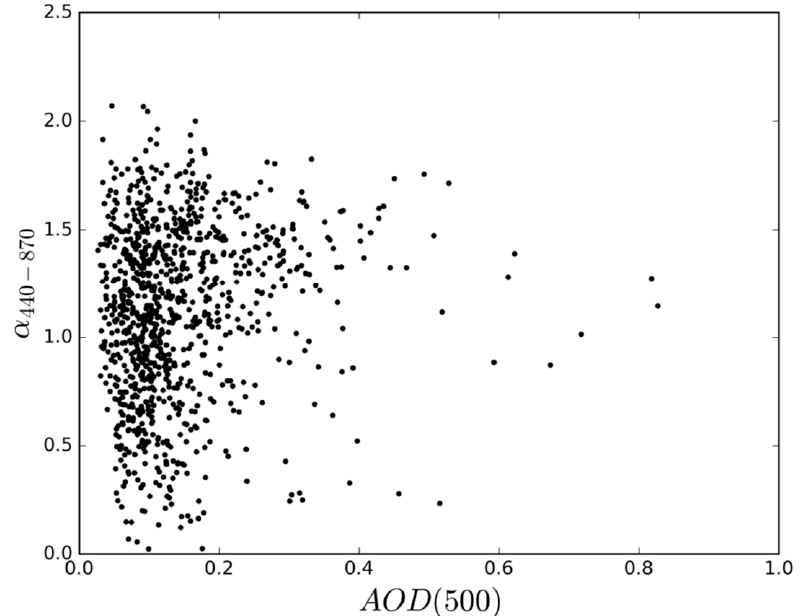
Figure 5. Mean daily observations of the Ångström coefficient ( α 440 − 870 ) as a function of the aerosol optical depth at 500 nm (AOD), during December 2008–May 2015 at the AERONET Arcachon lagoon station.